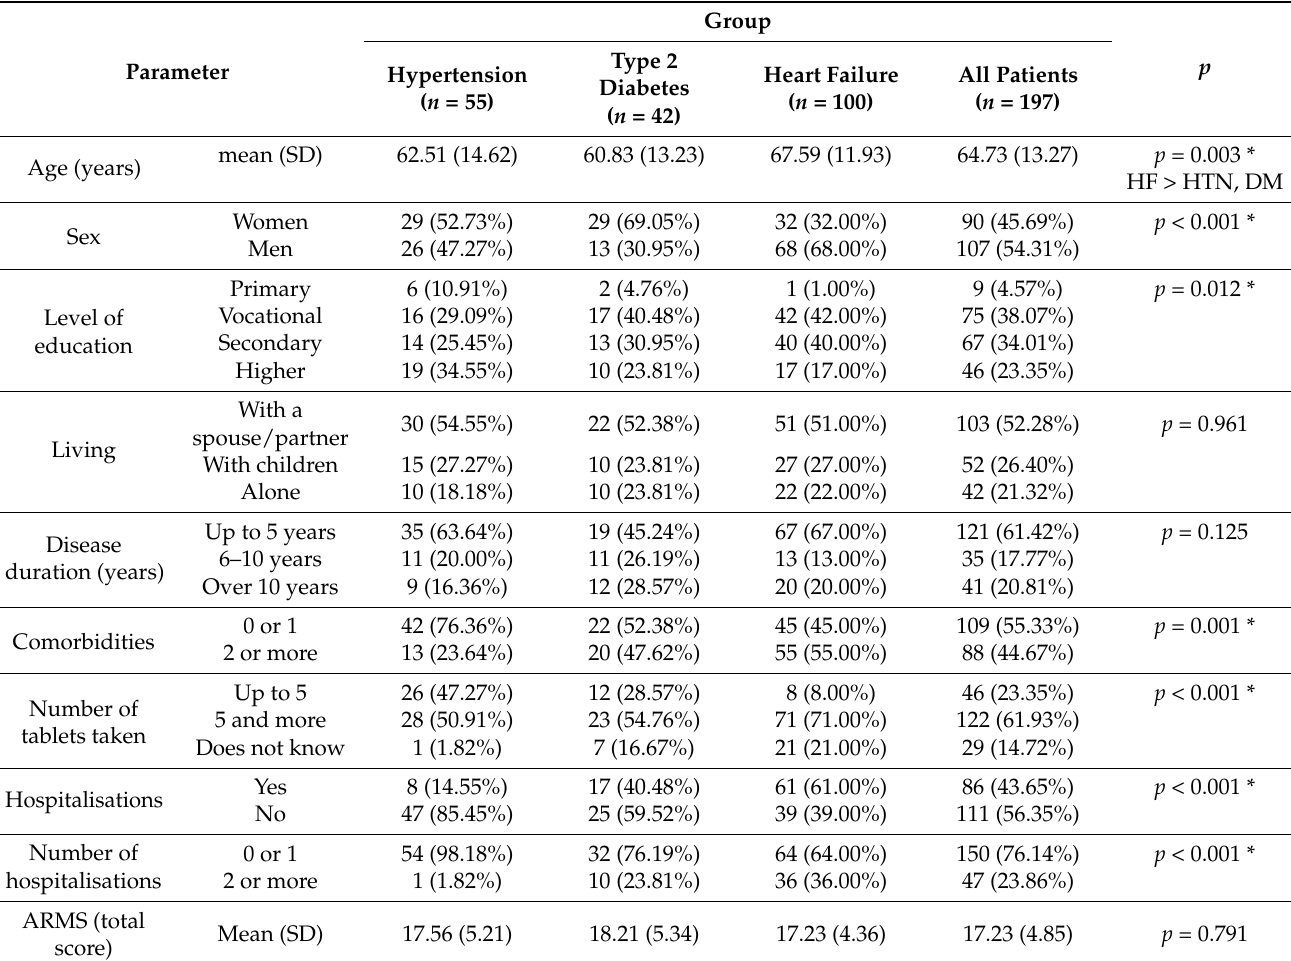
Table 1. The socio–clinical characteristics of the research